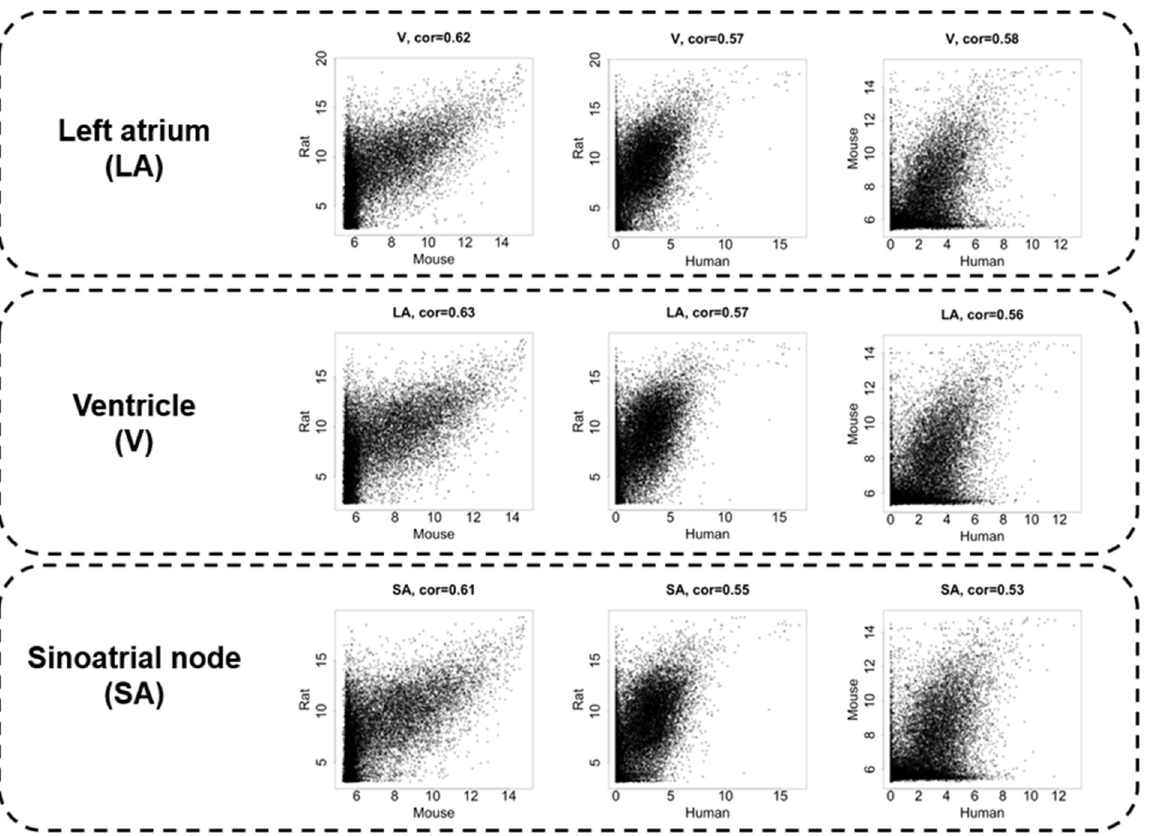
Figure 2. The expression intensity correlations between species are compared in the left atrium (LA), ventricle (V), and sinus node (SA), in order from top to bottom. The leftmost panels show the correlation between mice and rats, the middle panels show the correlation between rats and humans, and the rightmost panels show the correlation between humans and mice. Spearman’s correlation coefficient is displayed at the top of each graph.